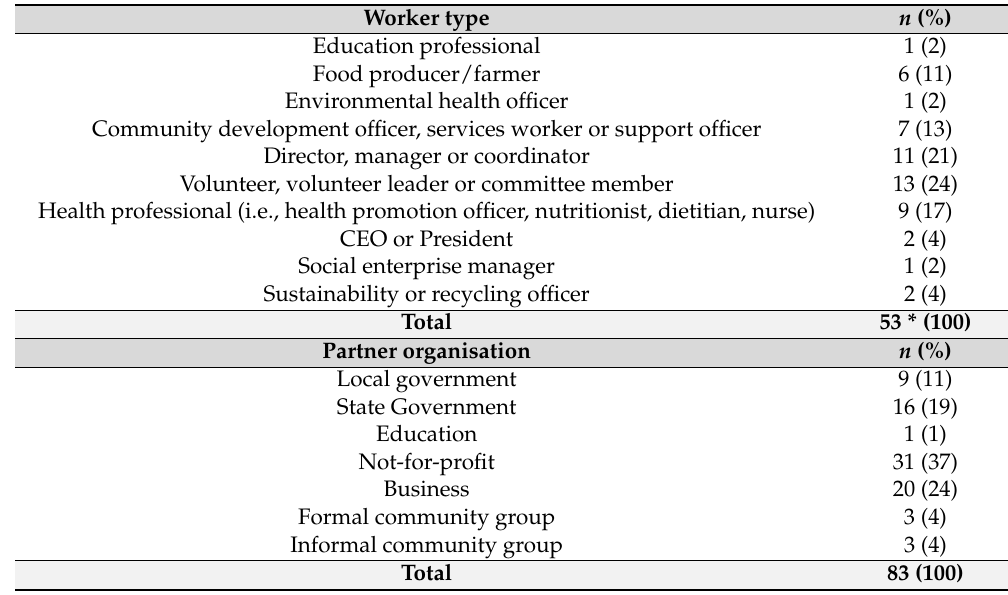
Table 1. Participant